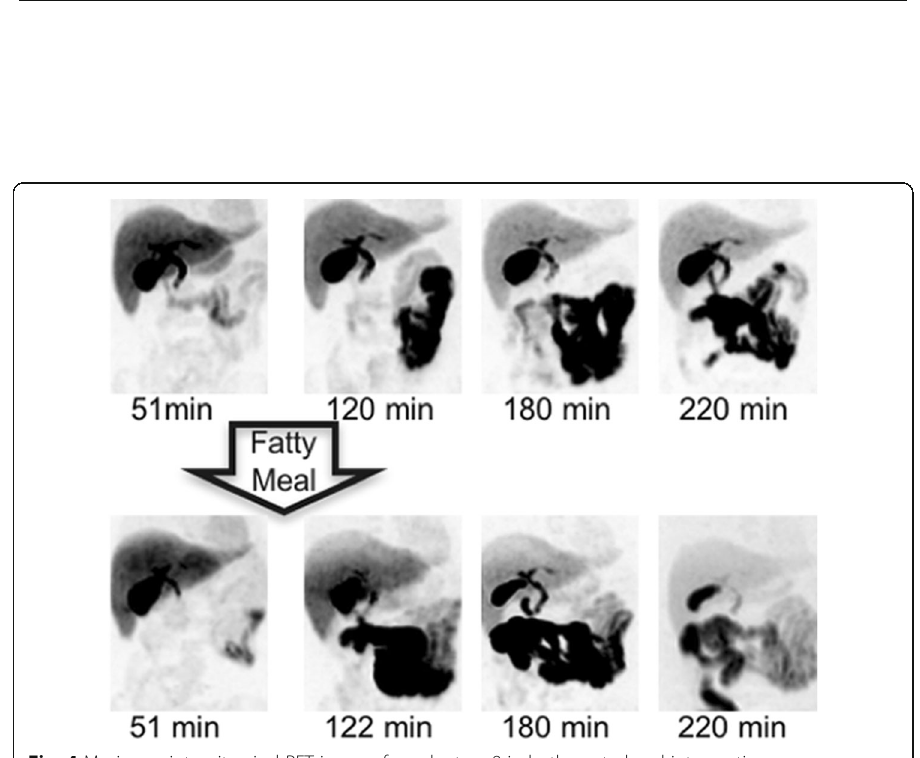
Fig. 4 Maximum intensity pixel PET images for volunteer 8 in both control and intervention groups. Legend: The upper row of images shows the original scans, while the lower image set details the gallbladder contraction over time following a fatty meal during the volunteer ’ s repeat